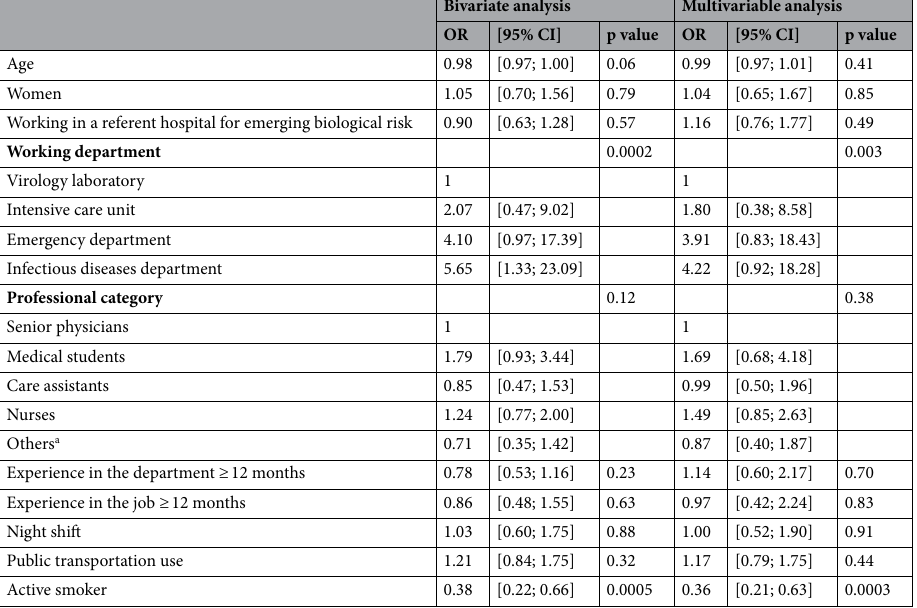
Table 4. Risk factors of laboratory-confirmed SARS-CoV-2 infection at M3 (after imputation of missing data; N = 1,062)). OR odds ratio, CI confidence interval. a Others include (but not limited to): secretaries, nurse’s managers, social